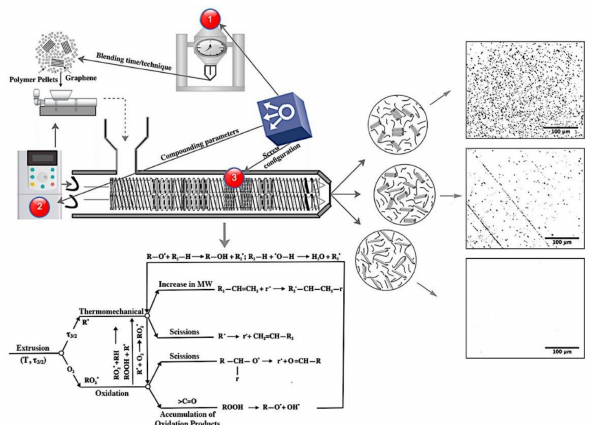
Figure 1. Simple schematic representation of the method followed in the present study. Gol’dberg–Zaikov model represents the general reaction mechanisms of all the thermo-mechanical and thermo-oxidative degradations that can occur during the melt extrusion of a polyethylene [24,25]. R represents the side chain of any hydrocarbon functional groups, r is the very short side chain of any hydrocarbon functional groups, MW is the molecular weight, denotes an active free radical site, and τ 3/2 is the shear stress in x and y